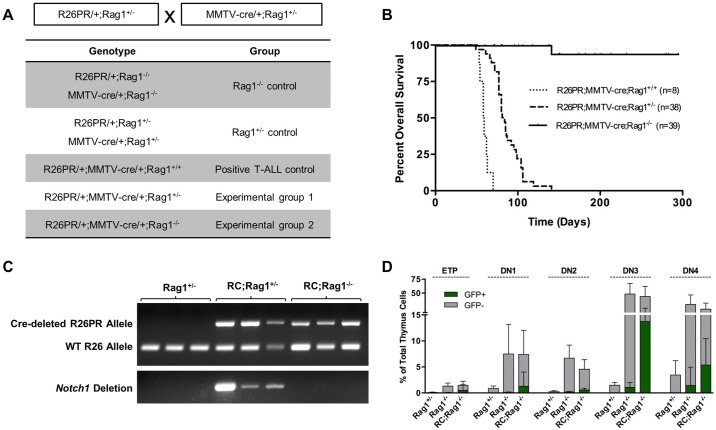
RAG recombination-impaired R26PR;cre mice do not develop leukemia or carry Notch1 deletions. (A) Breeding scheme and genotype grouping of Rag1 mutant mouse lines. (B) Overall survival of R26PR;MMTV-cre;Rag1+/+ (n=8), R26PR;MMTV-cre;Rag1+/− (n=38), and R26PR;MMTV-cre;Rag1−/− (n=39) mice. (C) PCR-based verification of R26PR allele status following exposure to Cre recombinase (upper) and PCR-based detection of Notch1 deletion status in R26PR;MMTV-cre mice with or without Rag1 (lower). RC, R26PR;MMTV-cre. (D) Flow cytometric analyses of early thymocyte development in the thymi of Rag1+/− (n=13), Rag1−/− (n=15), and R26PR;MMTV-cre;Rag1−/− (n=14) mice. Thymocytes were stained for CD4, CD8, c-kit, CD44, and CD25, then double negative (DN; CD4−CD8−) cells were separated into stages according the expression of c-kit, CD44, and CD25. ETPs, CD4−CD8−CD44+CD25−c-kit+; DN1, CD4−CD8−CD44+CD25−; DN2, CD4−CD8−CD44+CD25+; DN3, CD4−CD8−CD44−CD25+; DN4, CD4−CD8−CD44−CD25−. GFP-positive and -negative cells are displayed as green and gray bars, respectively, and mean±s.d. is shown for all graphs. RC, R26PR;MMTV-cre.